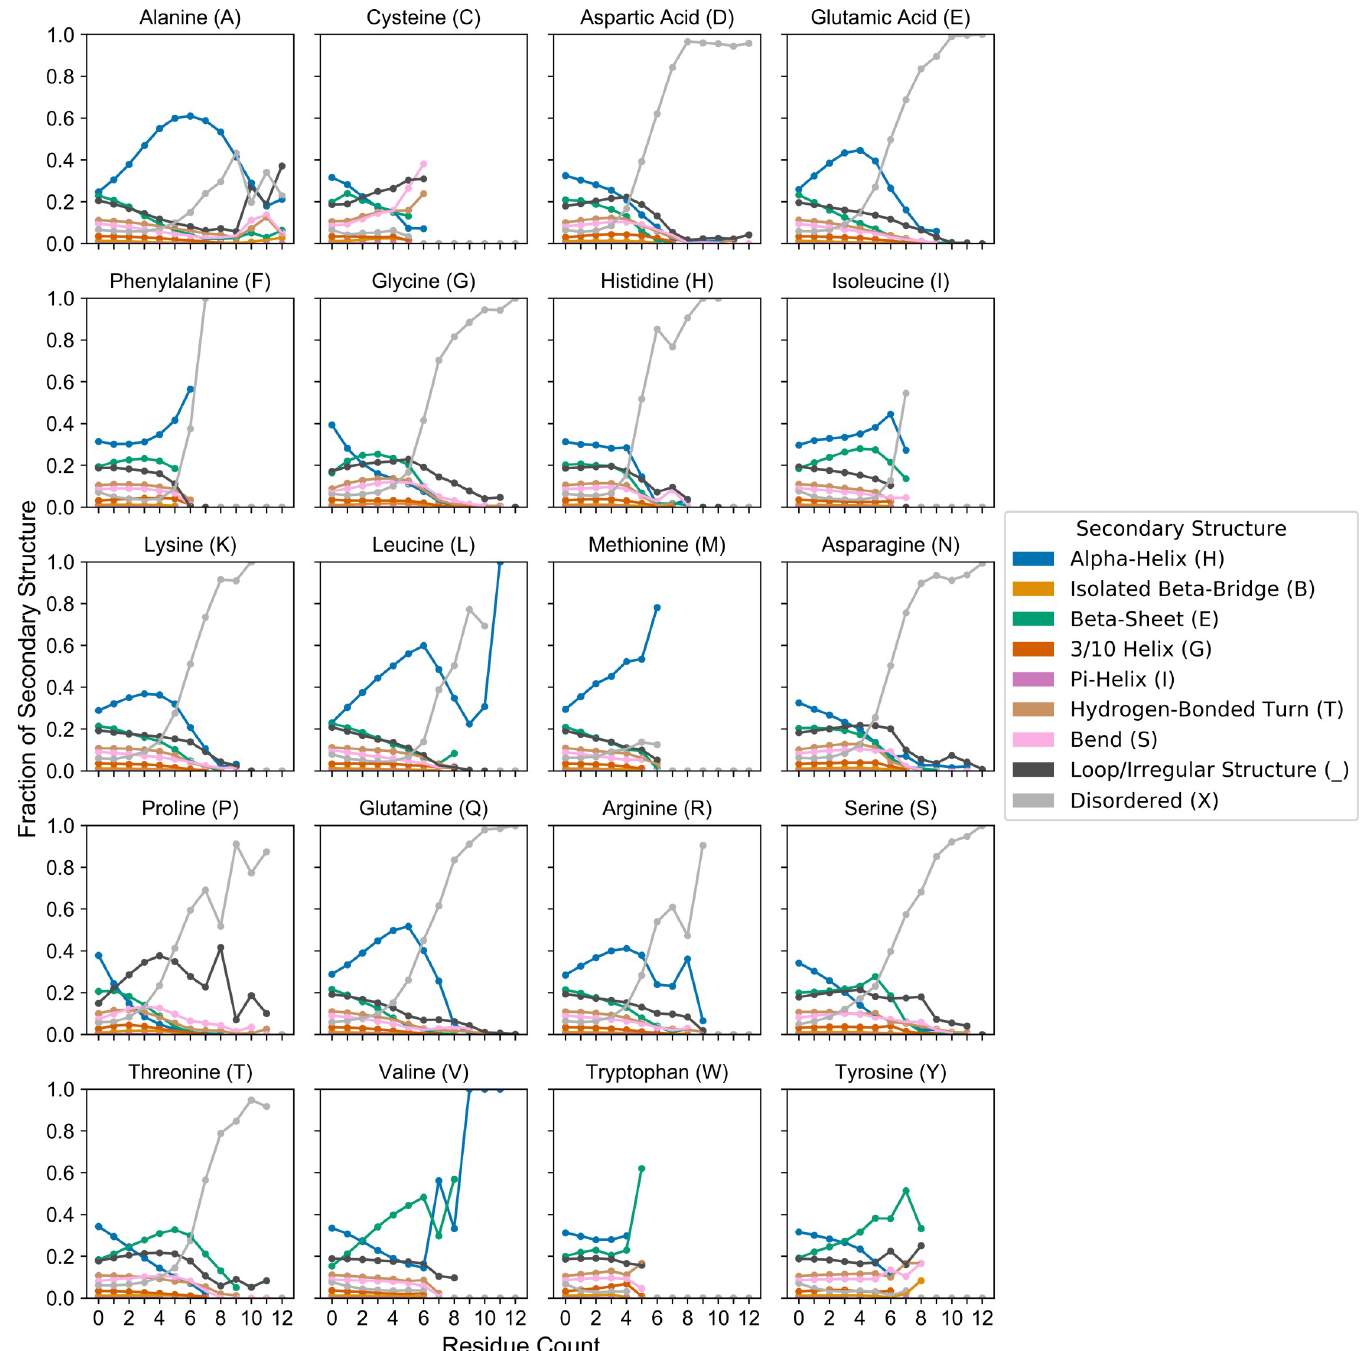
Fig 4. Conformational tendencies are highly dependent on both amino acid type and degree of enrichment. The PDB proteome was exhaustively scanned using a 12aa window size as depicted in Fig 3. Secondary structure tendencies across a range of enrichment for each amino acid are depicted in separate subplots. Within each subplot, scatter points represent the mean fraction of each secondary structure type across all peptide sequences within each indicated “residue count” bin. Sample sizes for all amino acids and residue count bins are indicated in S1